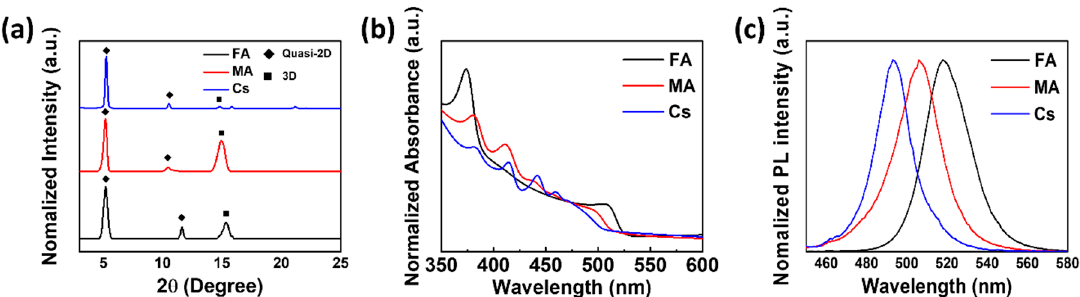
Figure 2. ( a ) X-ray diffraction (XRD) patterns of FA, MA, and Cs-based quasi-2D perovskite films. ( b ) Absorption, and ( c ) photoluminescence (PL) spectra of FA, MA, and Cs-based quasi-2D perovskite films.